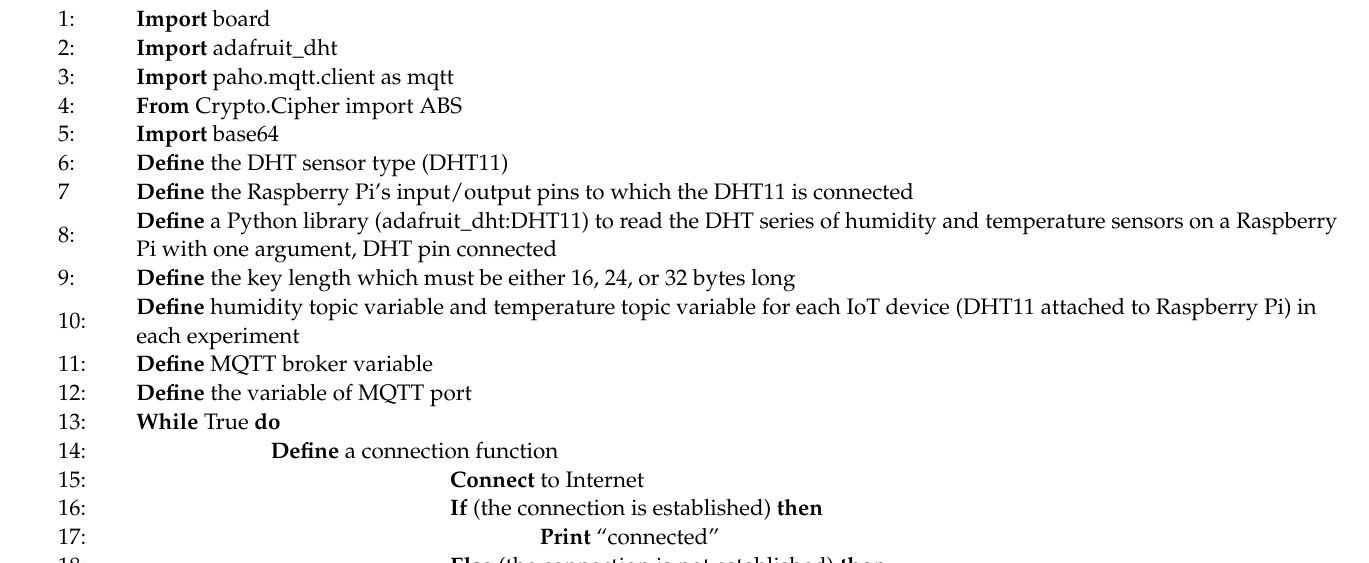
Algorithm 1: Collect data from the IoT device and send it to the fog device–IoT–Fog–Cloud architecture. This algorithm provides authentication and authorization operations from IoT devices (DHT11 sensor + Raspberry Pi) to fog